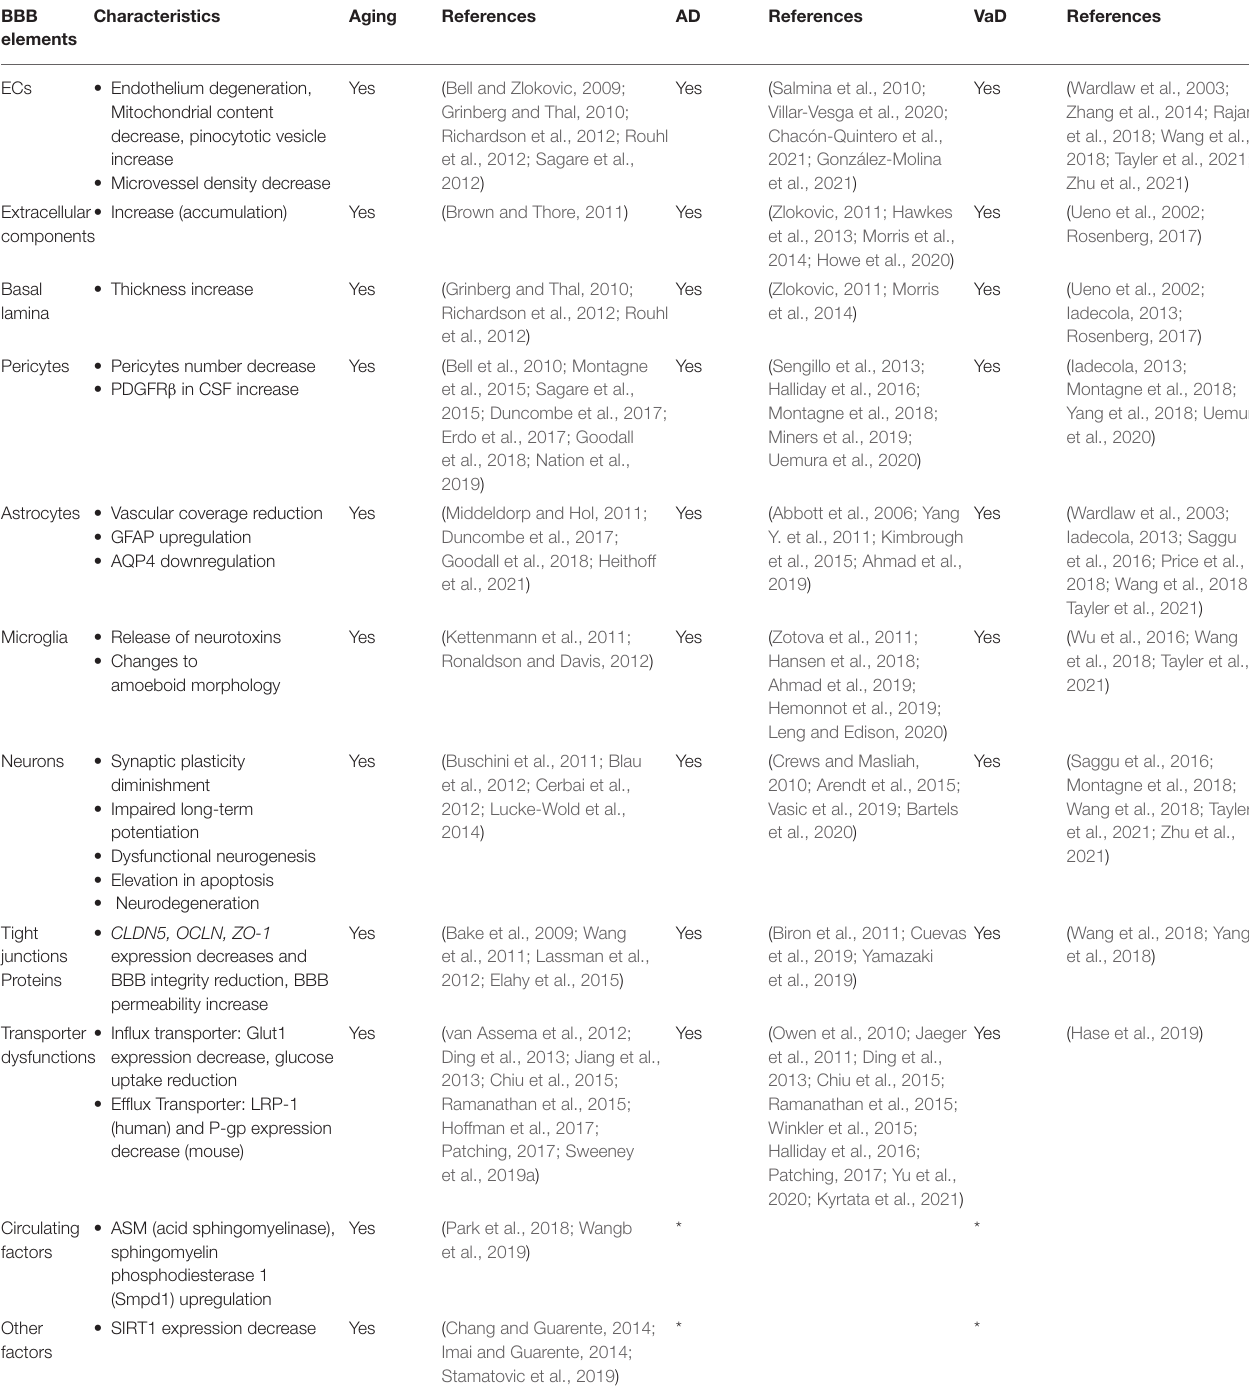
TABLE 1 | Changes associated with blood–brain barrier (BBB) breakdown in normal aging, Alzheimer’s disease (AD), and vascular dementia